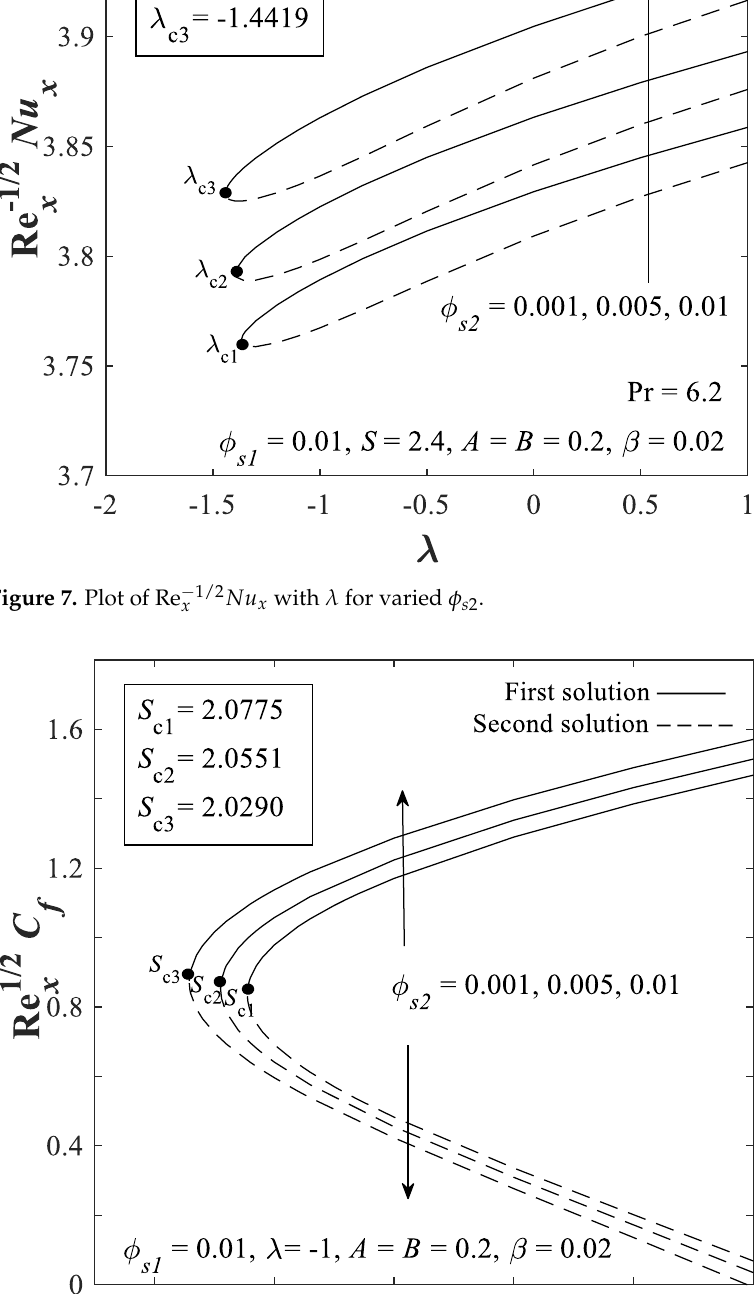
Figure 8. Plot of Re 1/2 x C f with S for varied φ s 2 Figure 8. Plot of 1/2 Re